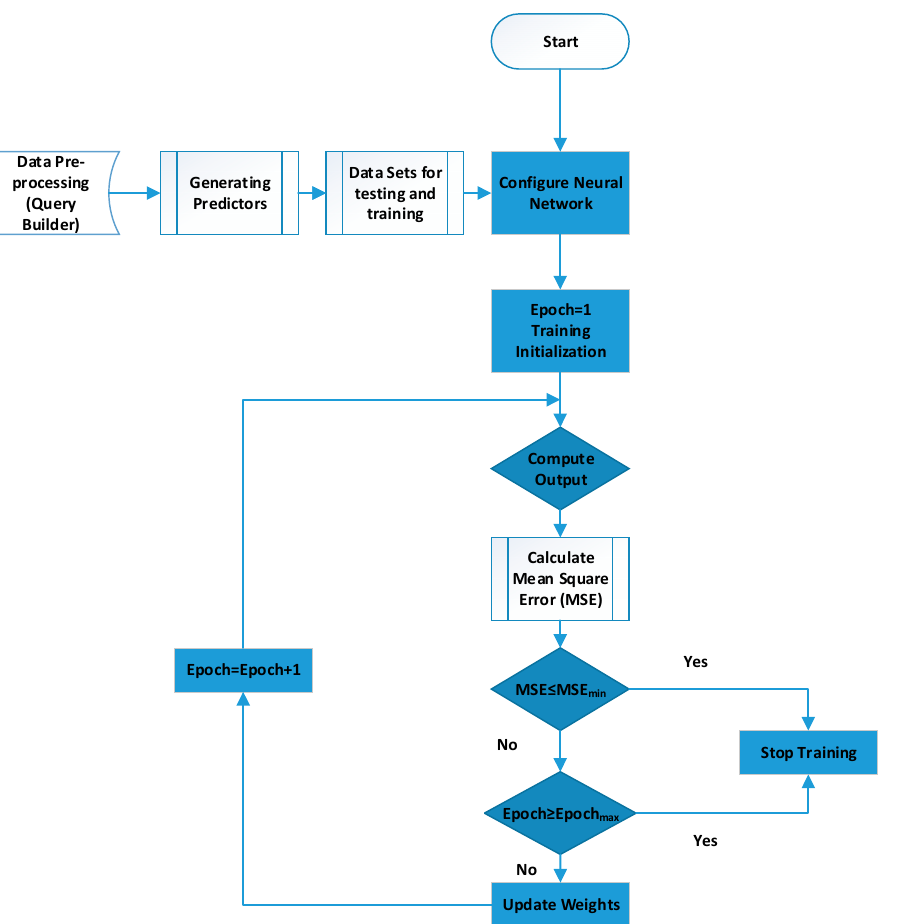
Figure 7. Parameter selection with the stopping criteria method.